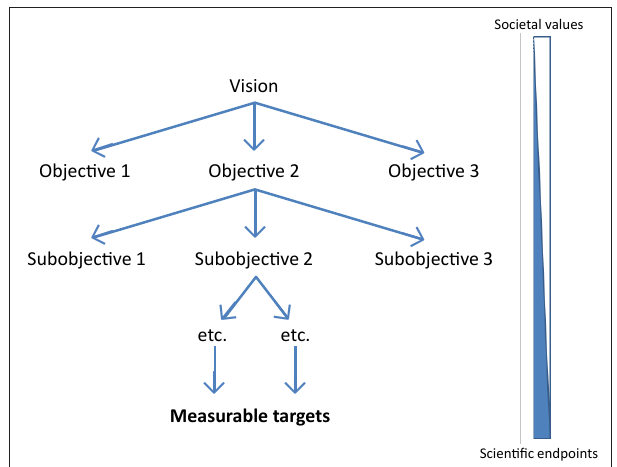
FIGURE 2: Generic objectives hierarchy that links the vision to scientific endpoints, based on the work of Pollard, S.R. & Du Toit, D.R., 2007, Guidelines for strategic adaptive management – Experiences from managing the rivers of the Kruger National Park. Guidelines of UNEP/GEF Project No. GF/27-13-03- 4679. Ecosystems, Protected Areas and People Project; Rogers, K. & Bestbier, R., 1997, Development of a protocol for the definition of the desired state of riverine systems in South Africa, Department of Environmental Affairs and Tourism, Pretoria; and Rogers, K.H. & Biggs, H.C., 1999, ‘Integrating indicators,